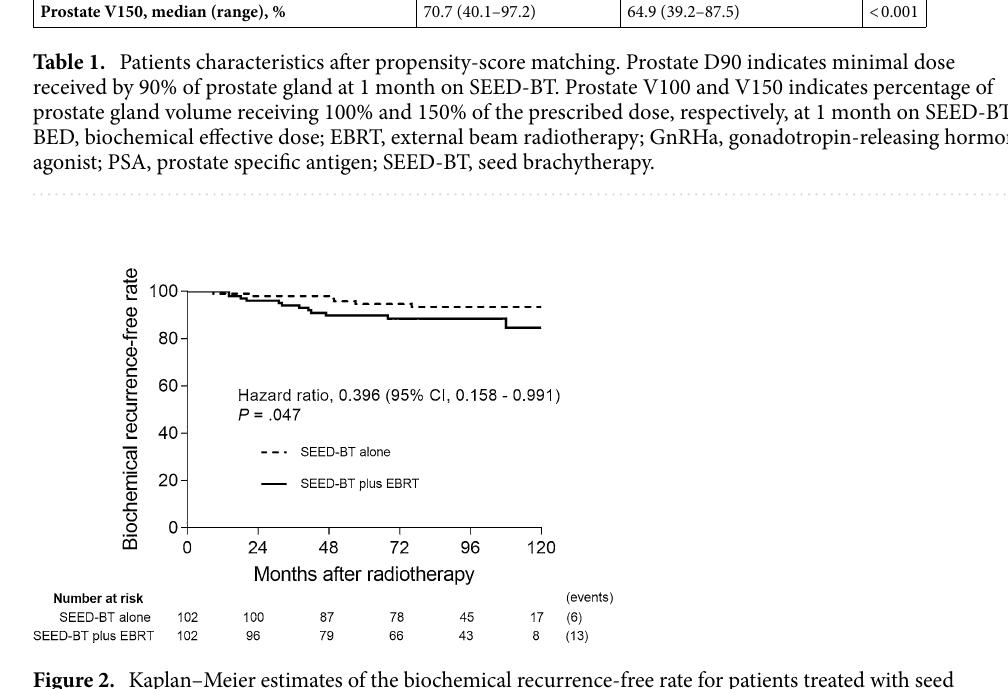
Figure 2. Kaplan–Meier estimates of the biochemical recurrence-free rate for patients treated with seed brachytherapy (SEED-BT) alone or with SEED-BT plus external-beam radiotherapy (EBRT), adjusted. CI = confidence